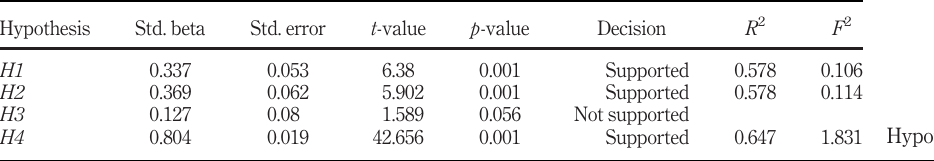
Table 9. Hypotheses fi